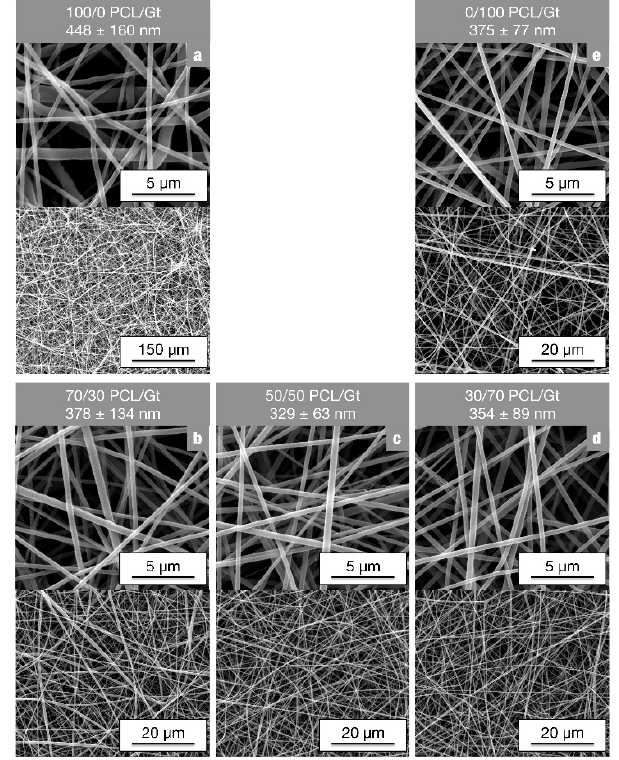
Figure 1. Scanning electron microscopy (SEM ) images of PCL/Gt blend nanofibers electrospun using